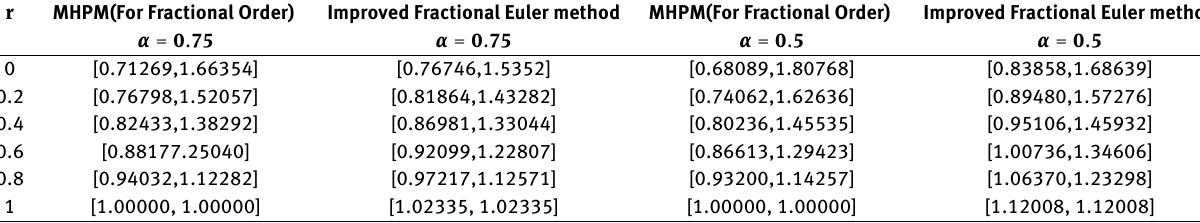
Table 6. Solutions obtained by MHPM and IFEM for h = 0.001 at t = 0.1 . For different values of α . r MHPM(For Fractional